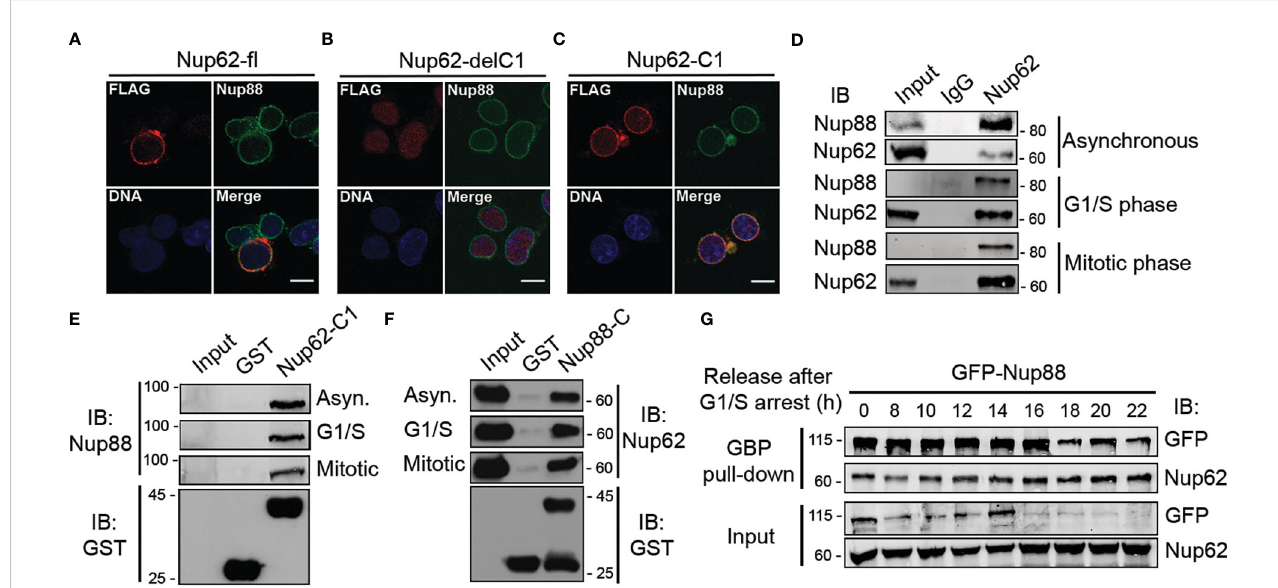
FIGURE 4 Nup88 interacts with Nup62 independent of the cell cycle phases. (A – C) Localization of FLAG-Nup62 constructs Nup62- fl , Nup62-delC1, and Nup62-C1 respectively in cells and detection by anti-FLAG (red) and anti-Nup88 (green) antibodies. Chromatin is stained with Hoechst 33342. Scale bar = 10 µm. (D) Immunoprecipitation using control and anti-Nup62 IgG from HeLa cell lysates synchronized in different phases (as indicated) of the cell-cycle. IP samples were immunoblotted with anti-Nup88 and anti-Nup62 antibodies. (E) Pull down on GST or GST-Nup62-C1 coated beads from HeLa lysates synchronized as indicated. Pull down material is immunoblotted with the anti-Nup88 antibody. The GST-tagged proteins were detected by anti-GST antibodies (bottom panel). (F) Same as in (E) , but the beads are coated with GST or GST-Nup88-C, and anti-Nup62 antibody used for immunoblotting. (G) GBP pull down from GFP-Nup88 expressing HeLa cell lysates prepared from cells released for indicated time intervals after synchronization at G1/S phase. Pull down, and input fractions were immunoblotted (IB) with anti-GFP and anti-Nup62 antibodies. Images are a representative from at least n=3 repeat